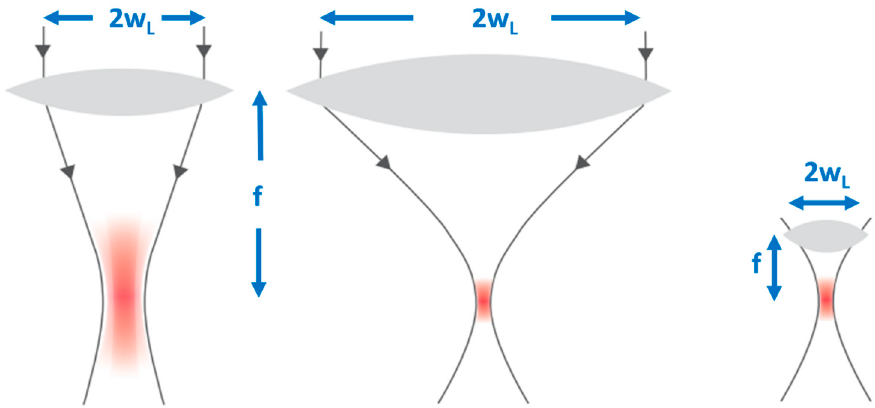
Figure 3. The focal volume of a Gaussian laser beam scales with the numerical aperture NA = w/f of the focusing lens. The larger the NA, the smaller the focal spot